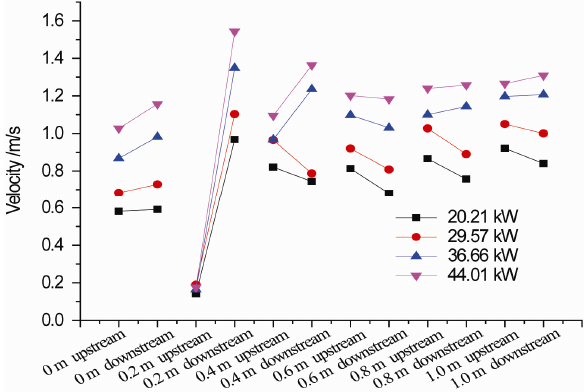
Fig. 2. Upstream and downstream smoke exhausting velocities at the shaft top